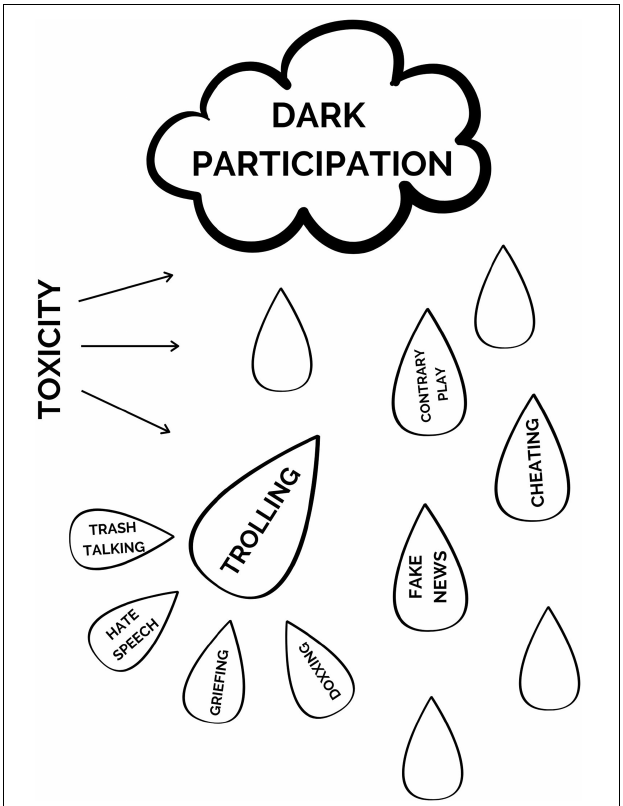
FIGURE 1 | Delineation of dark participation, toxicity, and trolling in online